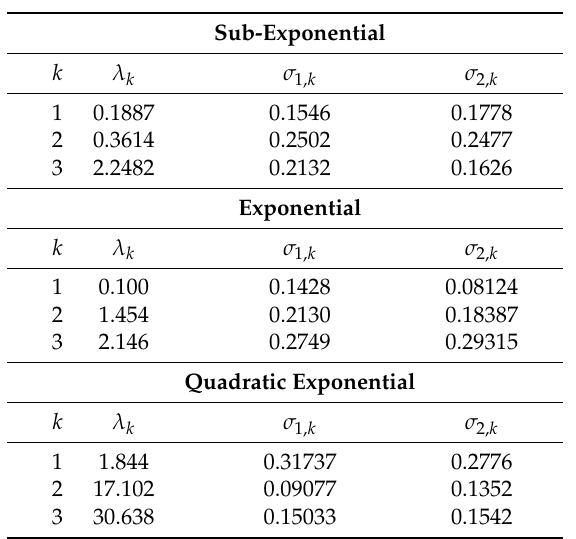
Table 3. Model parameters: Brent vs. WTI oil. Number of lags: 150 days and d =